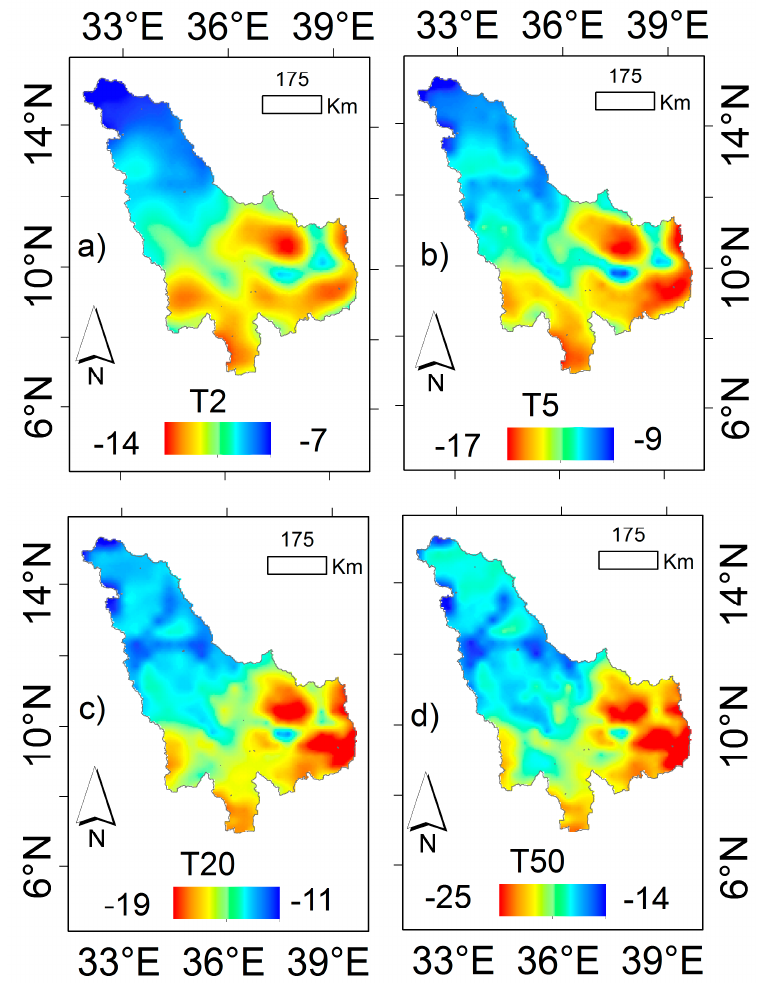
Figure A5. Meteorological deficit of: ( a , b ) mild; ( c ) severe; and ( d ) extreme drought quantile category. In the legend, e.g., T5 stands for return period of 5 years.